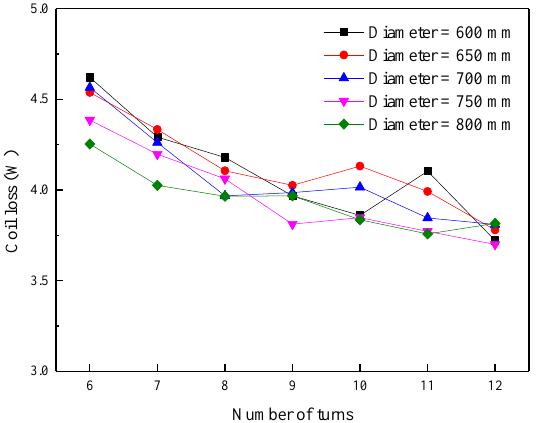
Figure 6. Coil loss vs. transmitter diameter and the number of turns.